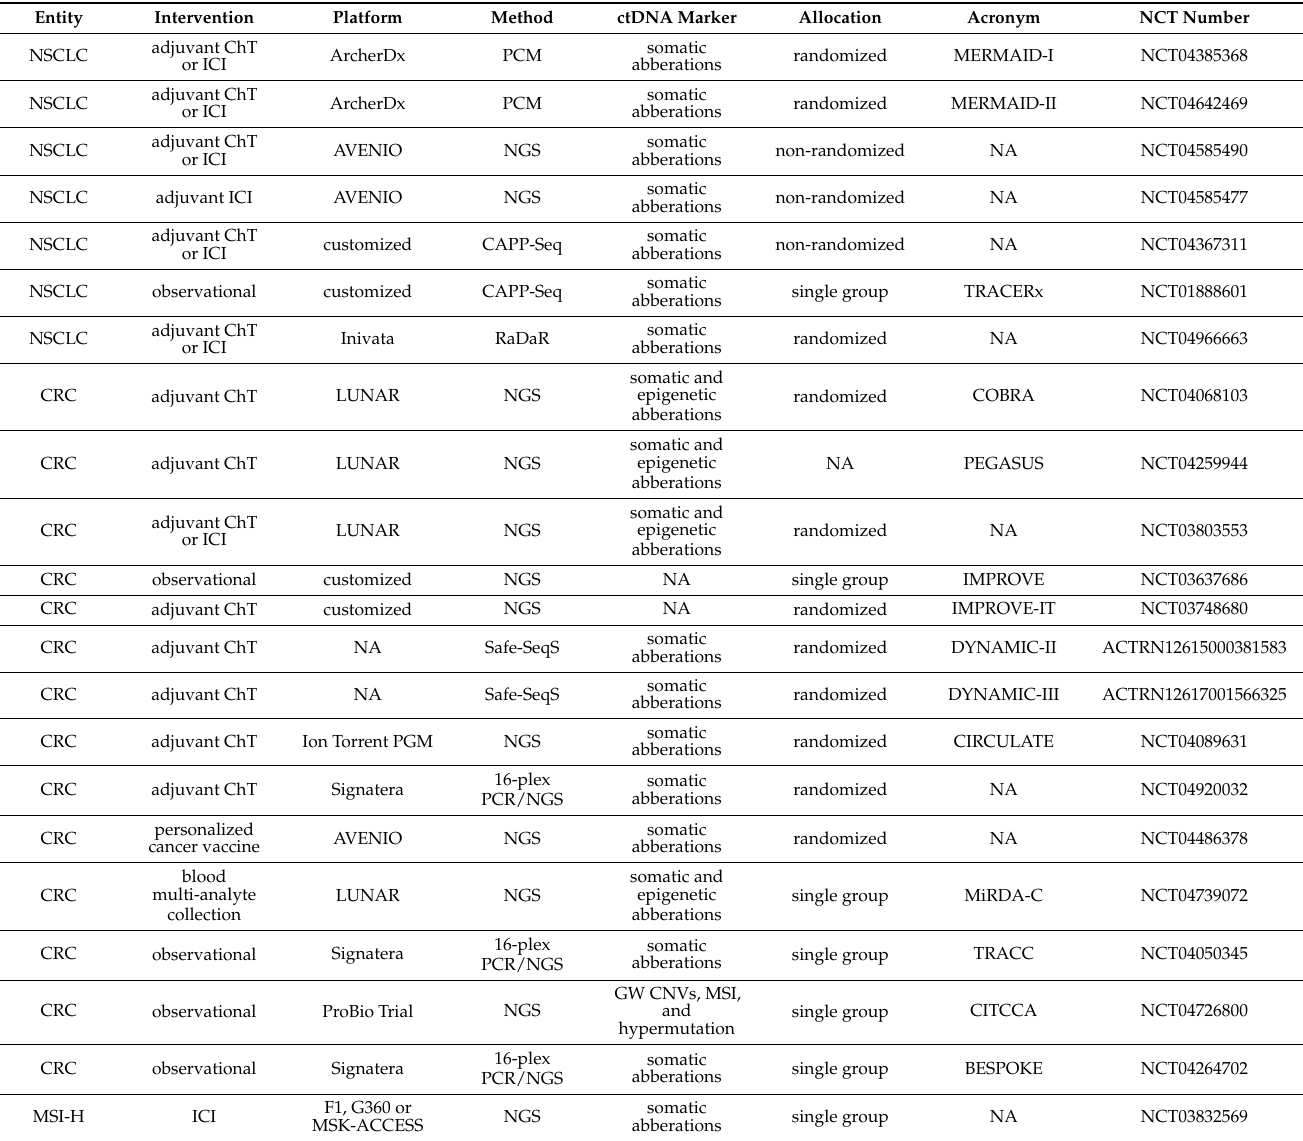
Table 2. Current clinical trials evaluating the utility of ctDNA detection in the adjuvant setting in NSCLC and CRC. ChT: Chemotherapy, ICI: immune checkpoint inhibitor, AVENIO: Surveillance Kit (ROCHE), LUNAR: Guardant Health, Signatera: